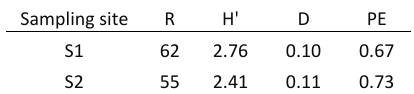
Table 3. Summary of species richness, evenness, and diversity of Table 3: Summary of species richness, evenness, and diversity of native and native and alien plants in Site 1 and Site 2, Mt. Manunggal, Cebu alien plants in Site 1 and Site 2, Mt. Manunggal, Cebu Island, Philippines. Island, Philippines.